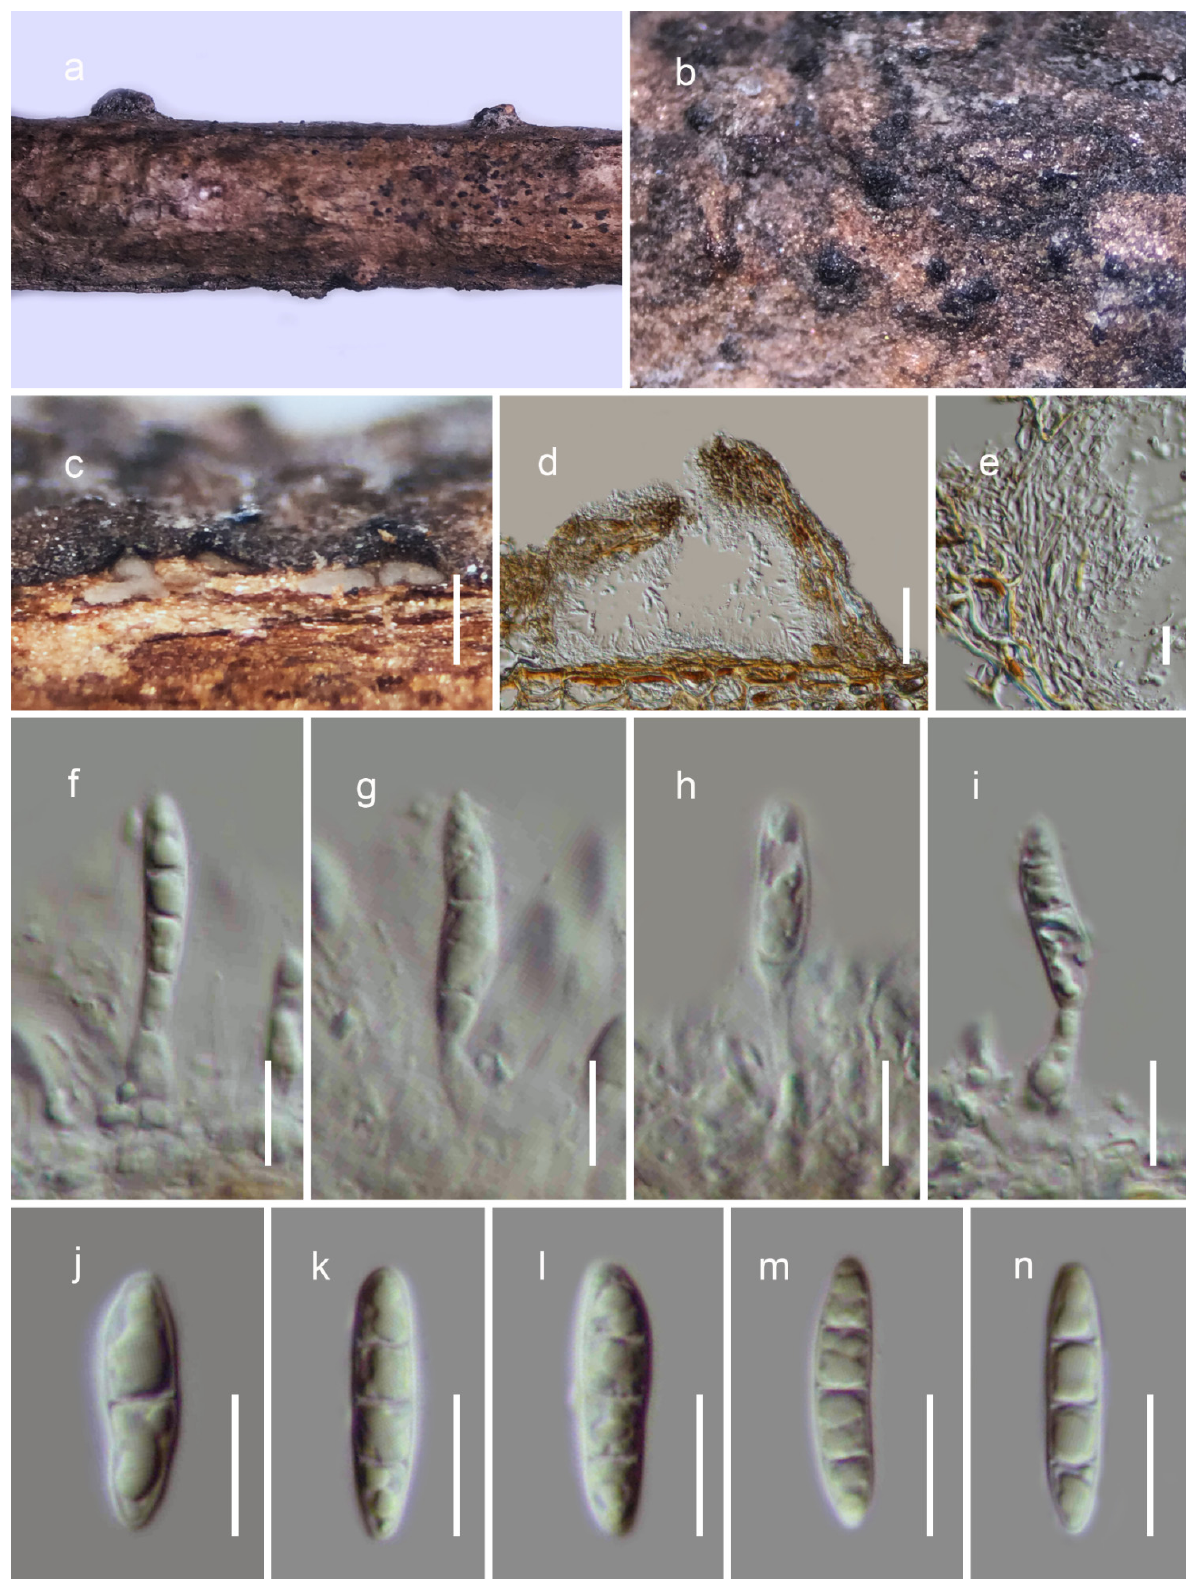
Figure 5. Kazuakitanaka lancangensis (HKAS122922, holotype). ( a , b ) Conidiomata on host surface; ( c , d ) sections through conidiomata; ( e ) conidioma wall; ( f – i ) conidiogenous cells and developing conidia; ( j – n ) conidia. Scale bars: ( c ) 500 μ m; ( d ) 50 μ m; ( e ) 15 μ m; ( f ‒ n ) 10 μ m.